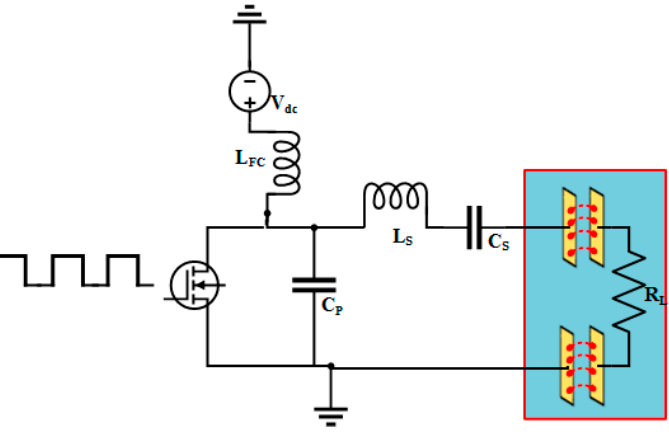
Figure 3. Class E power amplifier with CCWPT module.